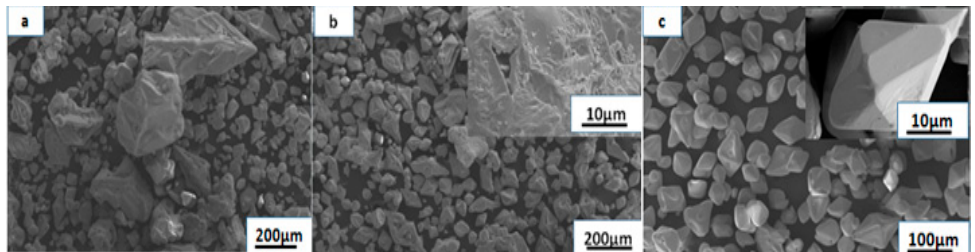
Figure 3. SEM images of recrystallized ammonium perrhenate particles at different agitation intensities and ammonium perrhenate raw material particles ( a ) ammonium perrhenate raw material particles, ( b ) 100 rpm stirring strength recrystallized particles, and ( c ) 200 rpm stirring strength recrystallized particles) [29]. Table 1. Specific surfaces and median diameters (D 50 s) of the NH4ReO4 particles.